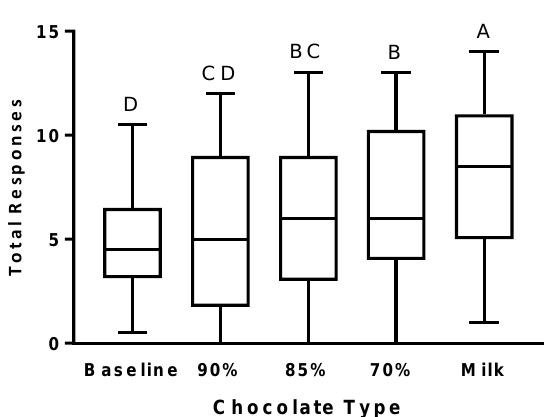
Figure 1. Total Psychophysical Effects Questionnaire (PEQ) scores after the consumption of chocolates differing in cocoa, sugar, and fat content. Self-reported scores on the PEQ questionnaire are presented as box and whiskers plots with the line representing the median, the box representing the 25th to 75th percentiles, and the whiskers representing the minimum to maximum values. Least-squares means are Baseline: 8.26 ± 1.16 (SE), 95% CI [5.93, 10.58]; 90% cocoa: 10.87 ± 1.10 (SE), 95% CI [8.65, 13.08]; 85% cocoa: 12.37 ± 1.10 (SE), 95% CI [10.15, 14.58]; 70% cocoa: 13.70 ± 1.10 (SE), 95% CI [11.49, 15.91]; Milk: 15.87 ± 1.10 (SE), 95% CI [13.65, 18.08]. Levels not connected by the same letter are significantly different.